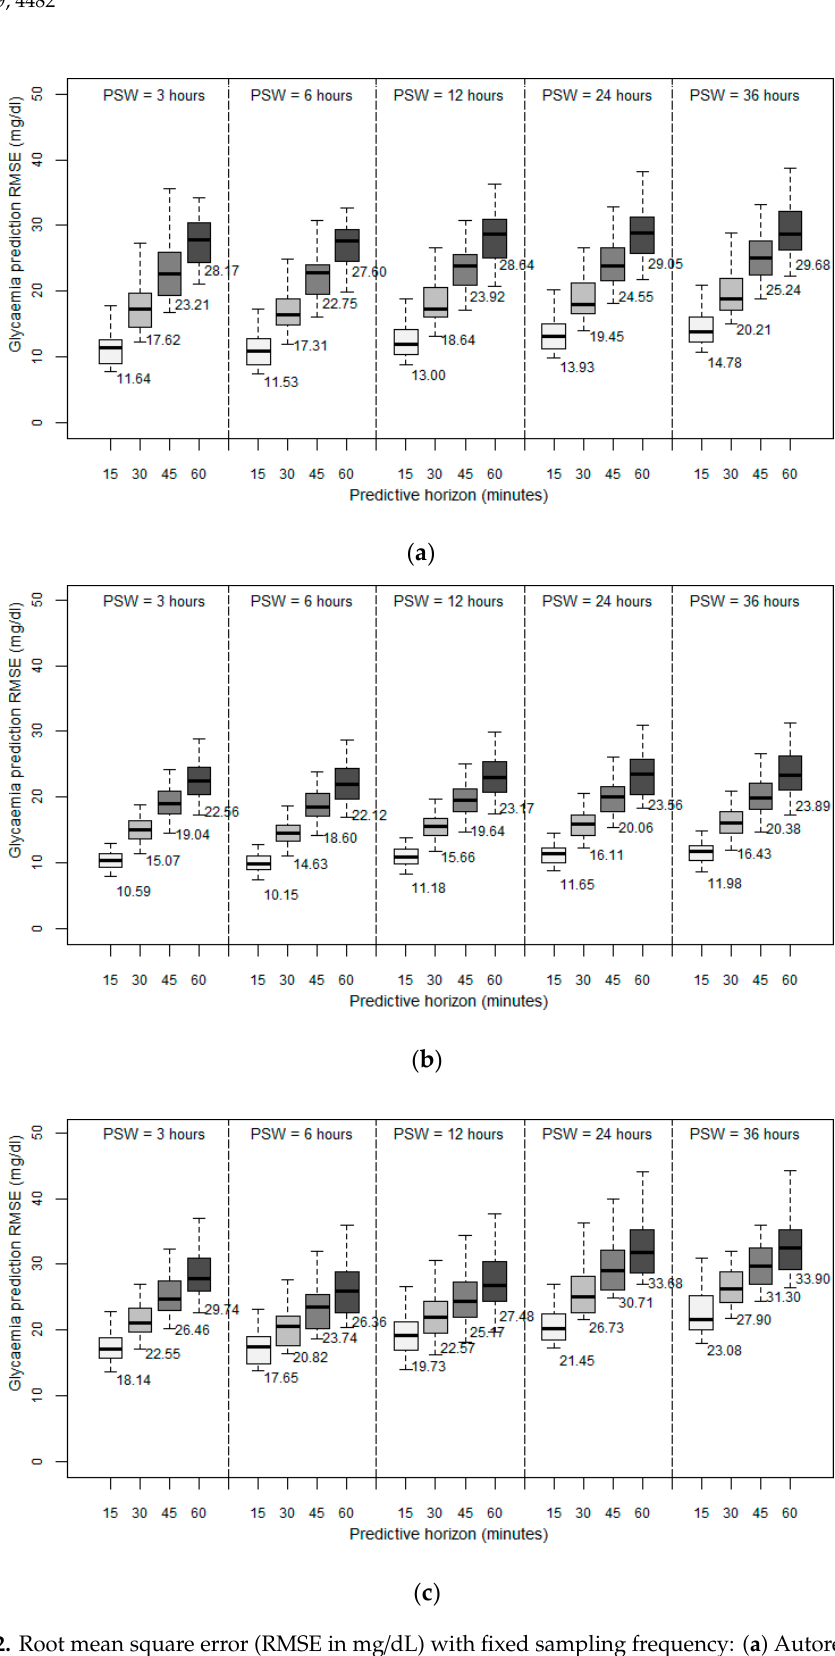
Figure 2. Root mean square error (RMSE in mg / dL) with fixed sampling frequency: ( a ) Autoregressive integrated moving average (ARIMA), ( b ) random forest (RF), and ( c ) support vector machine (SVM) with past sliding window sizes (PSWs) of 3, 6, 12, 24, 36 h; predictive horizons (PHs) of 15, 30, 45, and 60 min; and sampling frequency (SF) of 5 min.